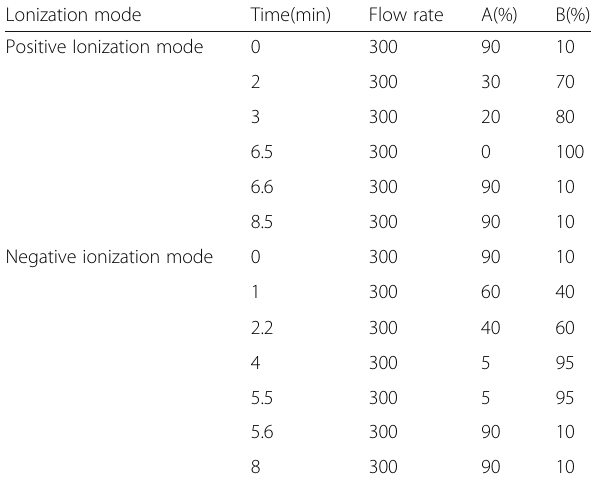
Table 2 The gradient program in the positive and negative ionization mode Lonization mode Positive Ionization mode